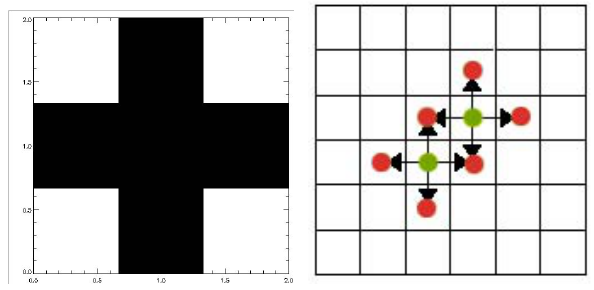
Fig. 13. Left: 3 × 3 structuring element used in the dilation. Black=1, White=0. Right: Example of creation of a broader re- gion. Green: original pixels. Green and red: expanded (dilated)